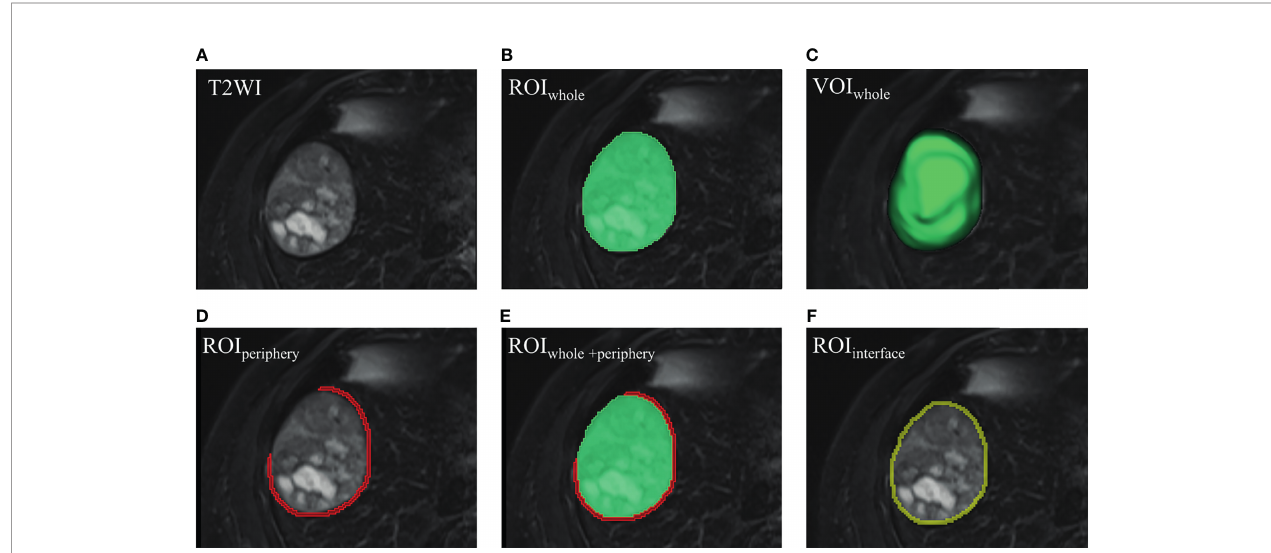
FIGURE 3 | Visualized segmentation images. (A) HCC lesion in T2WI. (B) ROI whole (green) was manually delineated slice by slice. (C) VOI whole (green) was automatically constructed, covering the whole tumor. (D) On the bases of VOI whole , VOI periphery was made hollow by replacing VOI whole with a peritumoral 5-mm-thickness zone, and the covering part was erased when encountering liver margin, gall bladder, or large vessels (like the inferior vena cava). (E) VOI whole + periphery was generated from the combination of VOI whole and VOI periphery . (F) VOI interface (yellow) was made by volume of 2-pixel automated dilation based on VOI whole subtracting volume of 2-pixel shrinkage based on VOI whole , termed the liver – tumor interface. Please note that one pixel is around 1.2 mm, and then 4-pixel-wide band is approximately 5 mm. (D – F) 2-dimensional view of the VOI periphery , VOI whole + periphery and VOI interface , respectively. ROI, region of interest. VOI, volume of